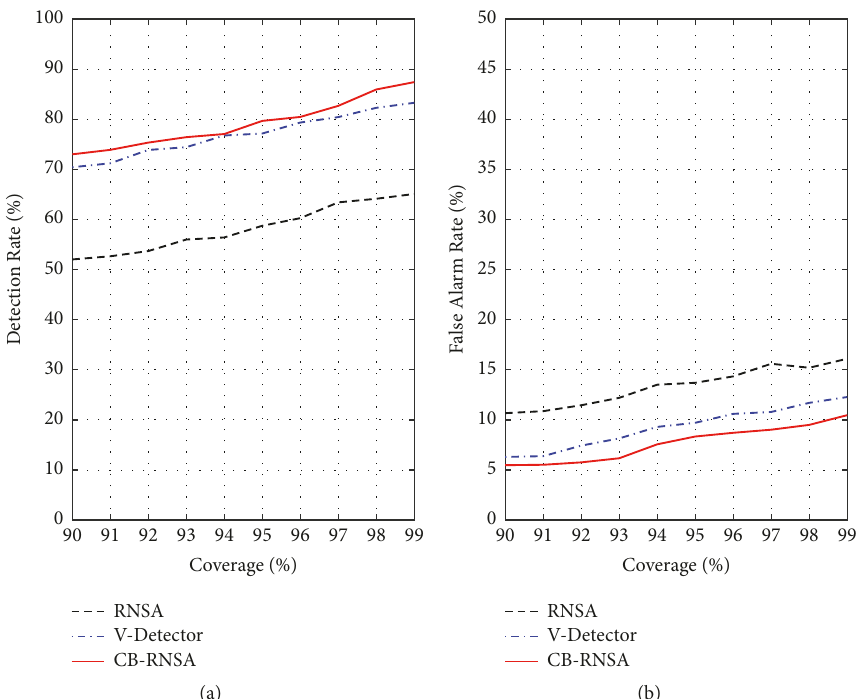
Figure 19: Comparisons of detection rates and false alarm rates of RNSA, V-Detector, and CB-RNSA (BCW2).